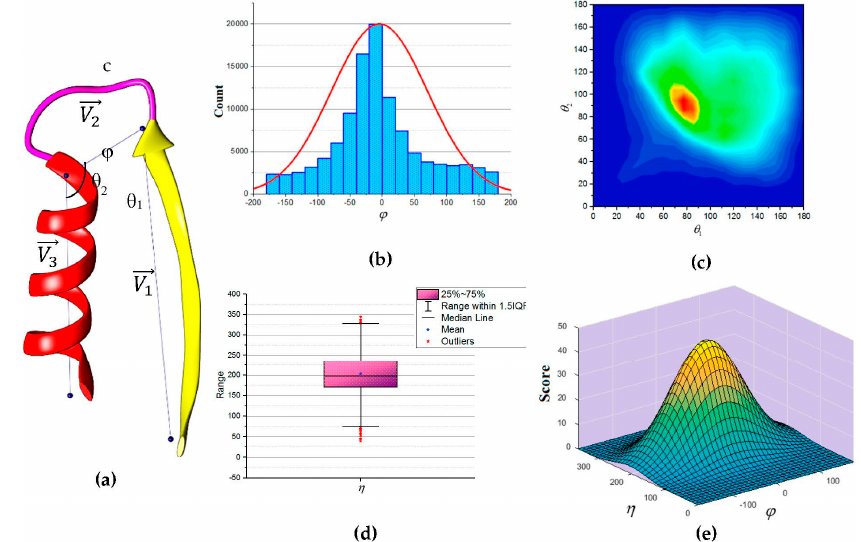
Figure 5. The geometry of consecutive secondary structures. ( a ) The three vectors describe the geometry of the secondary structures and the loop; ( b ) Histogram for the dihedral angle ( ϕ ). The curve is the normal distribution with a peak at zero; ( c ) Two-dimensional contour representation of the distribution of angles θ 1 and θ 2 . The ridge is along the diagonal line; ( d ) Box plot of the sum of the two packing angles ( η ). The box plot is clearly symmetrical overall. The quartiles Q1 and Q3 approximately the same distance from the median. The “whiskers” of the plot approximately the same length; ( e ) Schematic representation of the scaled bivariate normal distribution of the dihedral angle ( ϕ ) and the sum of two packing angles ( η